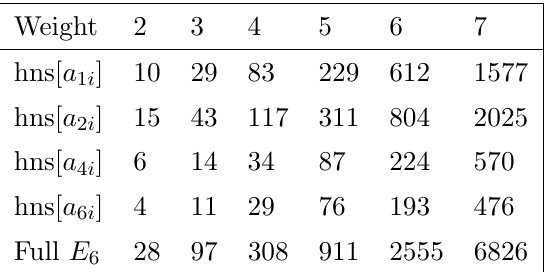
Table 2. Dimensions of the neighbour-set function spaces of the heptagon alphabet with initial entries a 1 i and the dimensions of the full cluster-adjacent heptagon